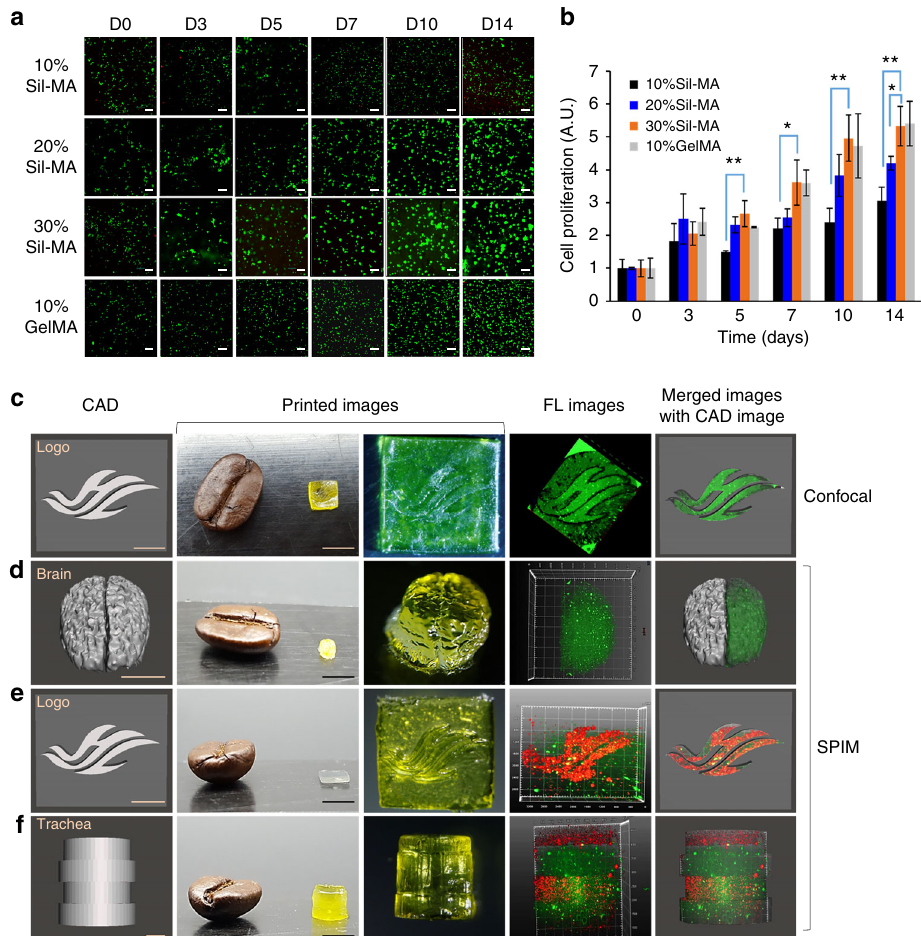
Fig. 6 Cytocompatibility of Sil-MA. a Live and dead assay; cell viability of encapsulated NIH/3T3 for 14 days (live cells in green and dead cells in red). Scale bar indicates 500 μ m. b CCK-8 assay; cell proliferation in the hydrogel for 14 days. The 30%Sil-MA hydrogel showed the similar cell proliferation to that of commercial GelMA (10%). * and ** refer to statistically signi fi cant proliferation p < 0.05 and p < 0.005 (two-sample t -test), respectively, compared to 30% Sil-MA hydrogels. The black line, blue line, orange line, and gray line indicate 10%, 20%, and 30% of Sil-MA hydrogel and 10%GelMA hydrogel, respectively. c – f Cell distribution inside the Sil-MA hydrogel. Cells were distributed evenly in the hydrogels. The Sil-MA hydrogels with c a design of the letter HL (the logo of Hallym University) and d a shape of human brain were printed out with PKH67-labeled cells only. Also, the Sil-MA hydrogels with e the letter HL and f a shape of winding trachea were printed out with PKH67-labeled cells (green) and PKH26-labeled cells (red); (from left to right) CAD images, printed images, fl uorescence images by c confocal or d – f single plane illumination microscopy (SPIM) microscope, and merged images of fl uorescence and CAD images. Scale bar indicates 1 mm on CAD images and 5 mm on printed images. Data are presented as mean ± s.d. Each assay